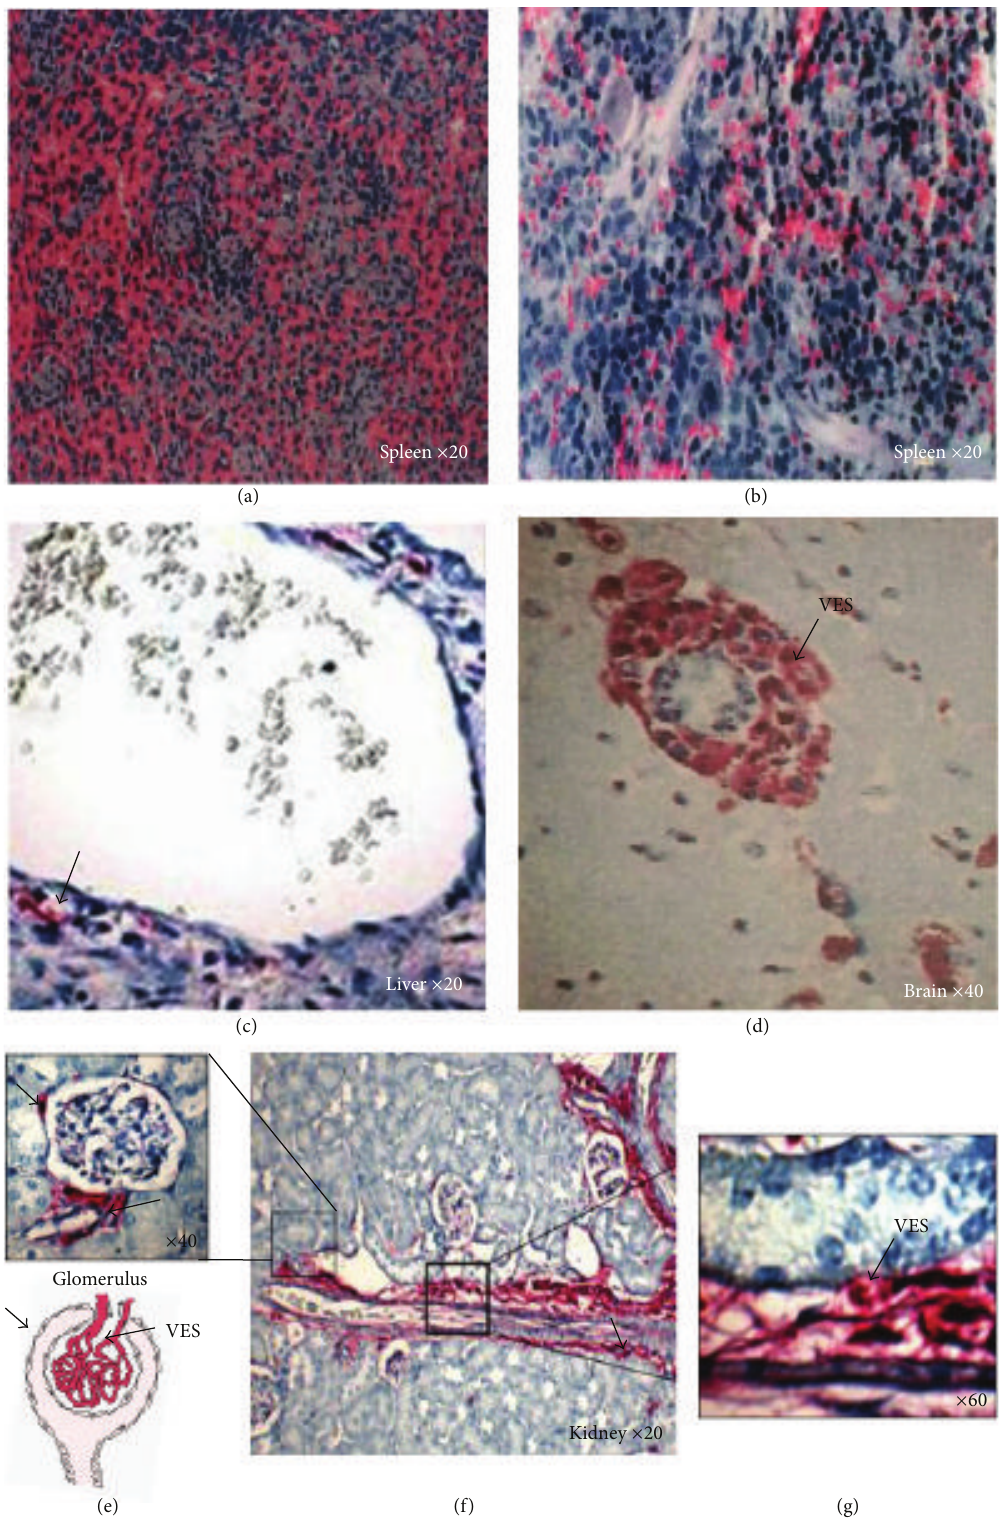
Figure 3: Histological examination of radiation exposed tissues by HES staining and human beta-2-microglobulin immunostaining in spleen and kidney. (a) illustrates a spleen of nonirradiated mice (control), (b) shows cell depletion 15 days after total body irradiation. The human cells expressing the human beta-2-microglobulin are stained in red. hMSCs migrated around the vascular axis (f), in functional structure such as glomerulus (e). Into glomerulus human cells have integrated both unitary structures: the glomerulus (e) and vascular endothelial system of this organ